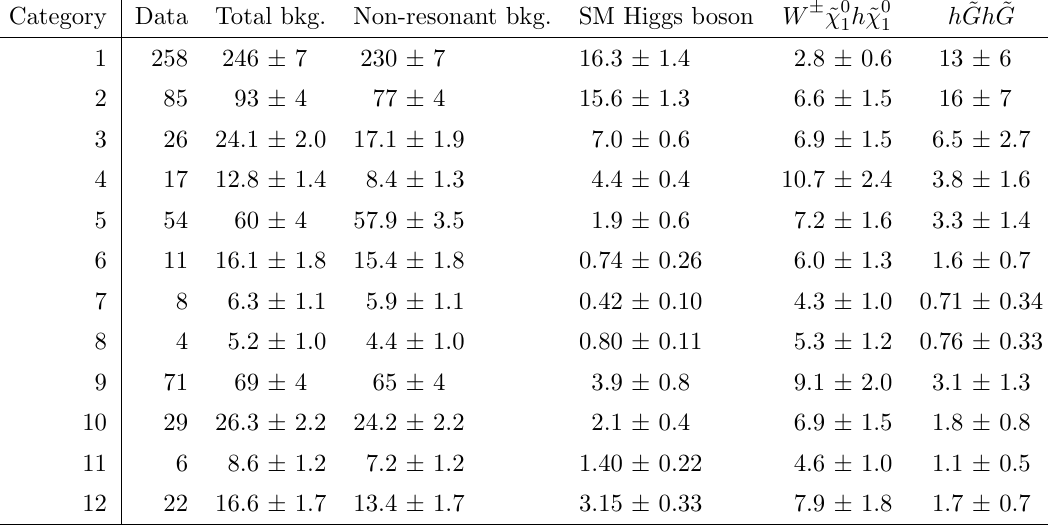
Table 4 . Event yields in the range 120 < m (cid:13)(cid:13) < 130 GeV for data, the signal models, the SM Higgs boson background and non-resonant background in each analysis category, for an integrated ! W (cid:6) ~ (cid:31) 0 luminosity of 139 fb (cid:0) 1 . The signal samples shown correspond to the ~ (cid:31) (cid:6) ~ (cid:31) 0 h ~ (cid:31) 0 signal with 1 2 1 1 m (~ (cid:31) (cid:6) = ~ (cid:31) 0 ) = 200 GeV and m (~ (cid:31) 0 ) = 0 : 5 GeV, and the h ~ Gh ~ G signals with m (~ (cid:31) 0 ) = 150 GeV and 1 2 1 1 m ( ~ G ) = 1 MeV. The yields for the non-resonant background and SM Higgs boson are obtained from a simultaneous background-only (cid:12)t to the full m (cid:13)(cid:13) spectrum for the 12 categories. The yields for the signals are estimated from the simulation. The uncertainties correspond to the statistical and systematic uncertainties summed in